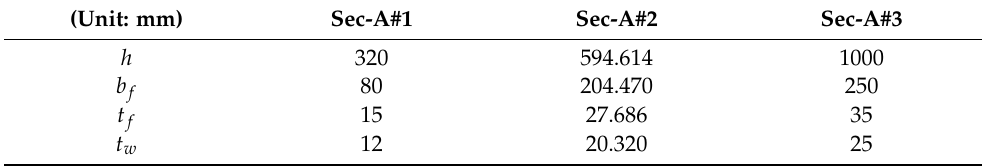
Figure 2. Boundary